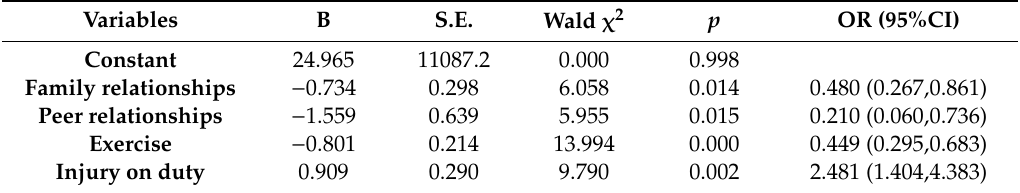
Table 3. The results of the logistic regression on the anxiety / depression dimension.